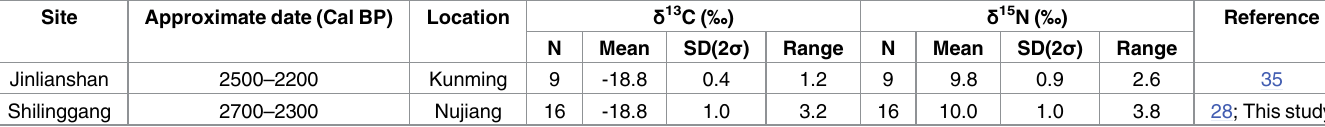
Table 4. Human collagen carbon and nitrogen isotope results from sites in